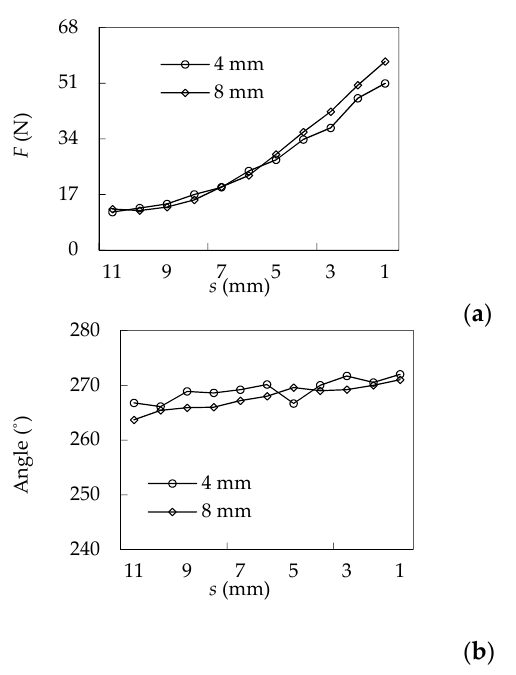
Figure 16. The effect of the top horizontal width of the sub-triangular NMC on EF (in the non- center line of the slot, ratio = 2, L = 0.03 mm): ( a ) the amplitude curve; ( b ) the phase curve. The top width of the NMC affects EF little under the condition of the large s . As s decreases, the EF difference between the width of 4 and 8 mm of the NMC begins to in- crease. The wider NMC provides the larger magnetic reluctance and the EF becomes larger. The maximum deviation angles are 6° and 3° for 4 and 8 mm of the NMC, respec- tively. The bottom horizontal width of the sub-triangular NMC in Figure 14 varies from 0.5 to 2 mm, and the EF is shown in Figure 17.